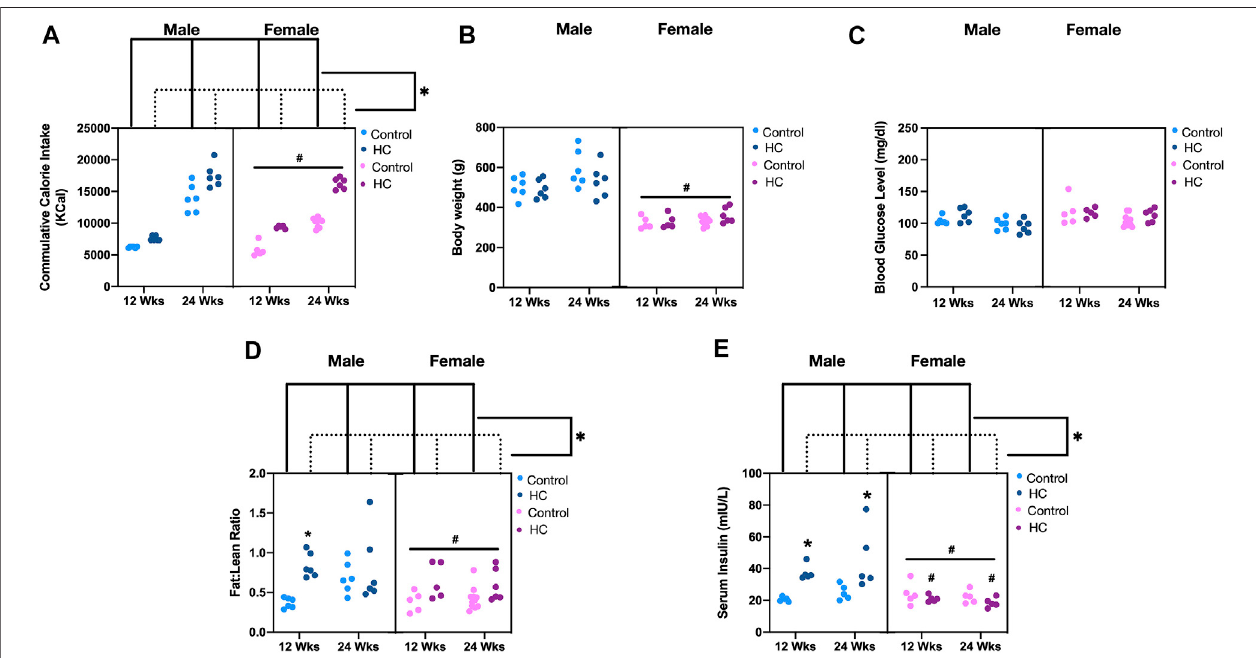
FIGURE1| Metabolicparametersofdifferentratgroups.Cumulativecalorieintake (A) ,bodyweight (B) ,bloodglucoselevel (C) ,fat:leanratio (D) ,andseruminsulin concentration (E) incontrol and hypercaloric diet (HC)-fed rats ofeither sexin different feeding durationgroups. Statistical analysis wasperformed bythree-way ANOVA followedbySidak ’ smultiplecomparison test.*denotes p < 0.05vs.controlgroupofthesame sexandfeedingdurationgroup(controlvs.HC), while#denotes p < 0.05 vs. the corresponding male group (males vs.